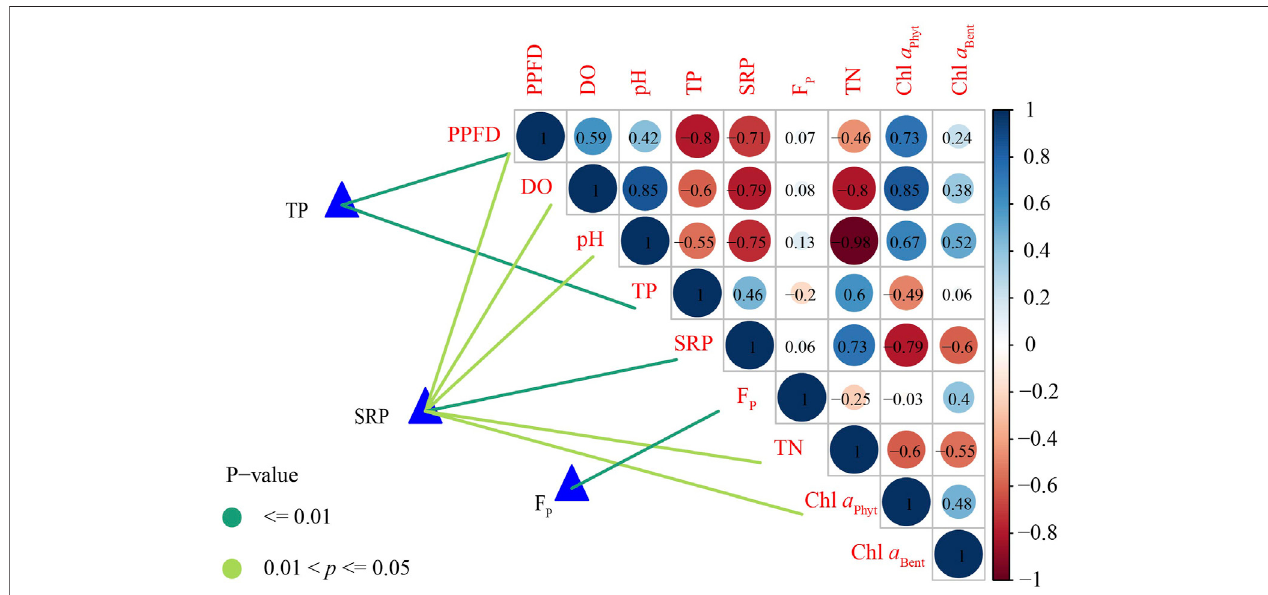
FIGURE 3 | Spearman rank correlation of phosphorus variables with environmental factors (blue: positive correlation; red: negative correlation; color shade and circle size: proportion to correlation coef fi cient; number: correlation coef fi cient). Total phosphorus (TP), soluble reactive phosphorus (SRP) and P release fl ux (F P ) were related to each environmental factor by Mantel tests (edge color denotes statistical signi fi cance) (PPFD, photosynthetic photon fl ux density; DO, dissolved oxygen; TN, total nitrogen; Chl a Phyt , phytoplankton chlorophyll a ; Chl a Bent , benthic algae chlorophyll a